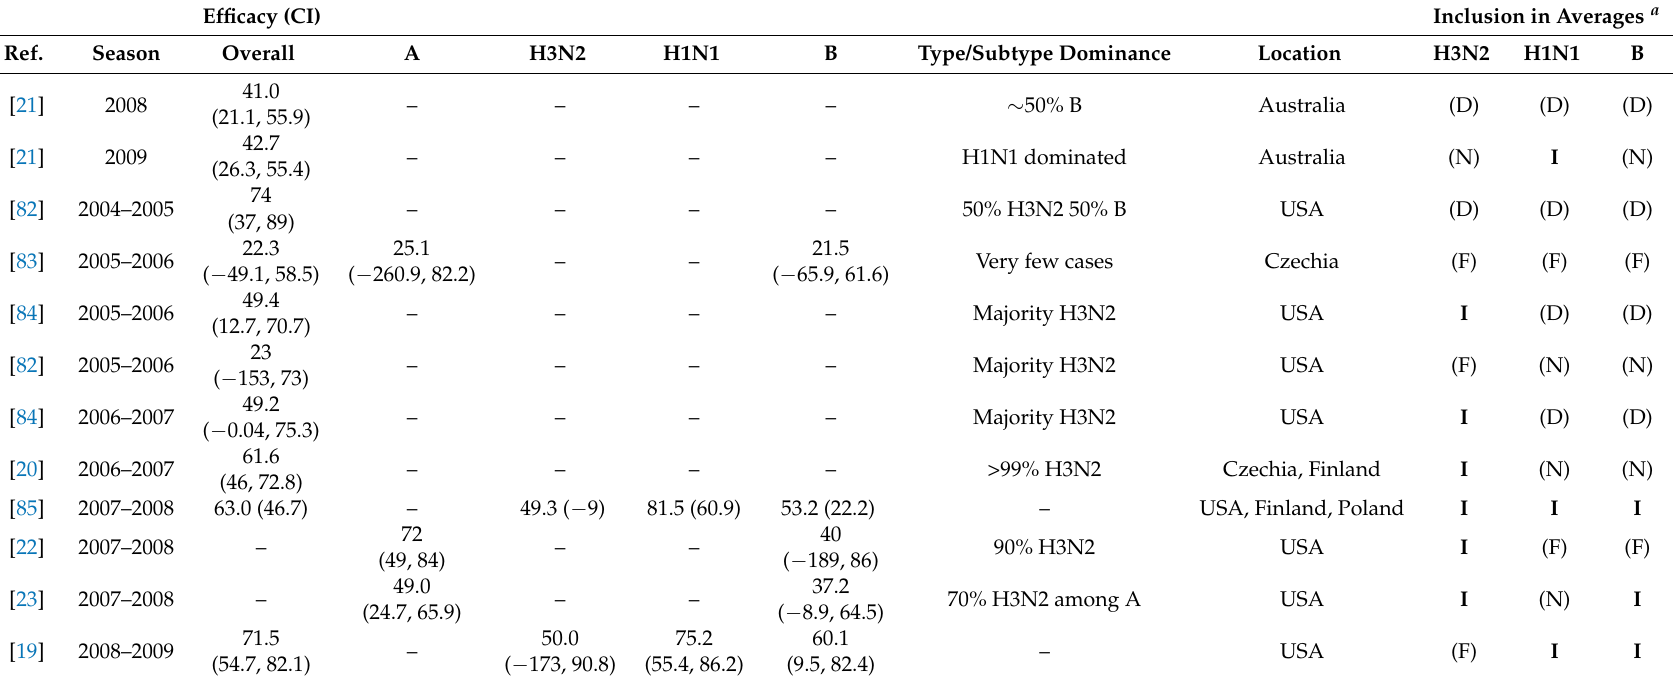
Table A1. Vaccine efficacy in adults measured in randomized control